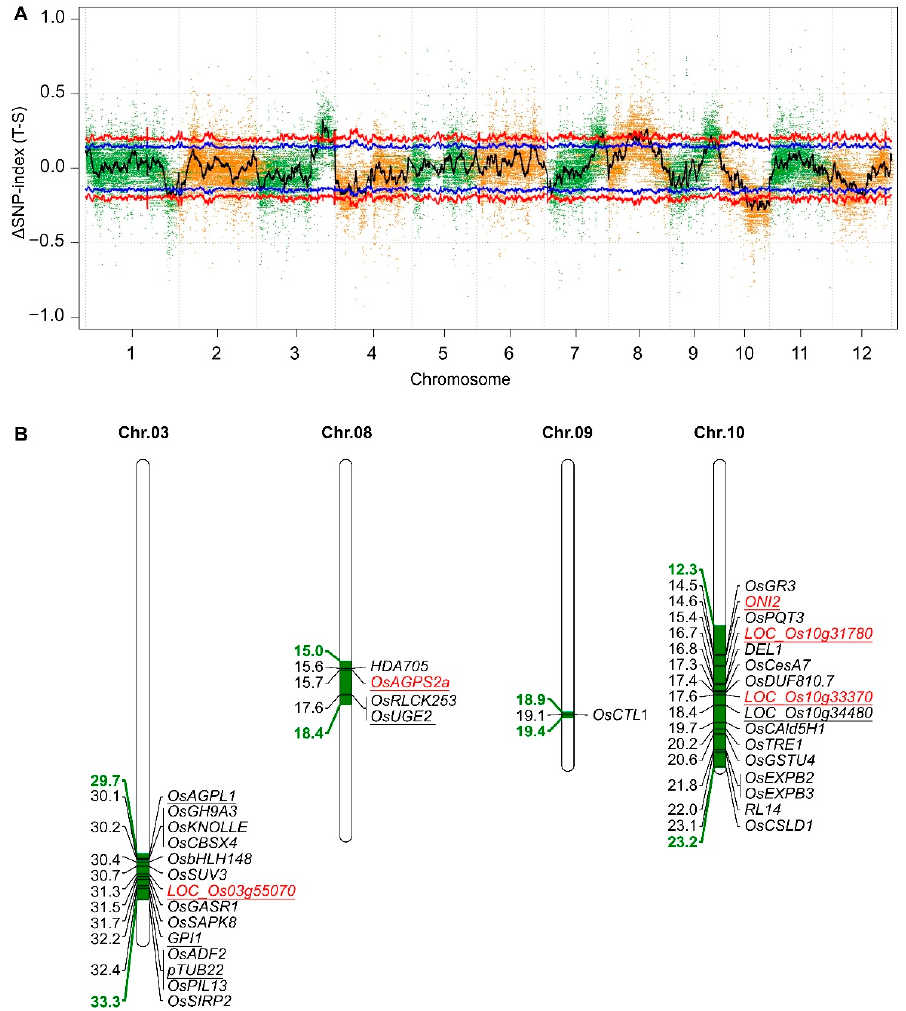
Figure 4. Mapping of the candidate genes of salt–alkali tolerance in SATR. ( A ) Whole-genome map- ping of the candidate genes controlling saline–alkali tolerance in SATR by GBTS. Dense and green or orange spots in the plot represent the ∆ SNP-index (T-S) between T-bulk and S-bulk (T-bulk–S-bulk). T-bulk and S-bulk represent the bulk DNA samples extracted from 30 individual seedlings showing the most extremely tolerant and susceptible phenotypes against SSAS treatment, respectively. Black curved line means the average ∆ SNP-index (T-S) calculated based on 1 Mb interval with a 100 kb sliding window. Red and blue curved lines in the plot mark the 99% ( p < 0.01) and 95% ( p < 0.05) statistical confidence intervals under the null hypothesis of no gene was identified within the confidence intervals. ( B ) Locations of the predicted candidate genes controlling saline–alkali tolerance in SATR. The chromosome 7 is not shown because the predicted candidate genes controlling saline–alkali tolerance in SATR were not identified in the mapping region on chromosome 7. Green and bold numerals on the left side of the chromosomes indicate the physical positions of the preliminary mapping region in which the predicted candidate genes are located. Black numerals on the left side of the chromosomes indicate the physical positions of the corresponding predicted candidate genes on the right side of the chromosomes within the preliminary mapping regions. Underlined genes represent the encoding genes of the hemicellulose and pectin biosynthesis pathway and the β -tubulin protein (Figure 2), as well as the encoding genes of the cutin, suberin and wax biosynthesis pathway (Figure 3). Genes marked with red color mean expressions levels of these genes were significantly higher in SATR seedlings than 93-11 on the 4th day after SSAS treatment. Chr., chromosome; GBTS, genotyping by target sequencing and liquid